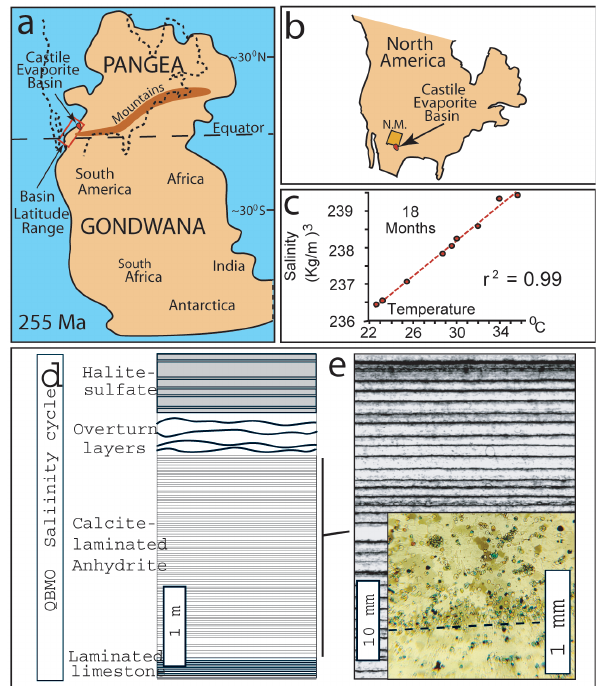
Fig. 1. Location, petrologic cycles, and varves of Castile Fm. (a) Map of Pangea in Late Permian (after Scotese, 2010). Rectangle is range in location of Castile evaporite. Dashed map is location of North America in Late Permian Pangea. (b) Map of North Amer- ica (dashed) and location of Castile evaporite basin relative to New Mexico. (c) Linear relationship of salinity and temperature in Dead Sea surface brine (Gertman et al., 2009). (d) Complete petrologic- salinity cycle and varve types of the QBMO. Low salinity varves at base to high salinity halite varves at top. (e) Photo of typical carbonate-sulfate layers (varves) in laminated Castile Fm. Dark, thin layer is organic-enriched calcite, light layer is anhydrite. Inset shows colored rhombic crystals of calcite comprising a carbonate layer. Dashed lines marks onset of